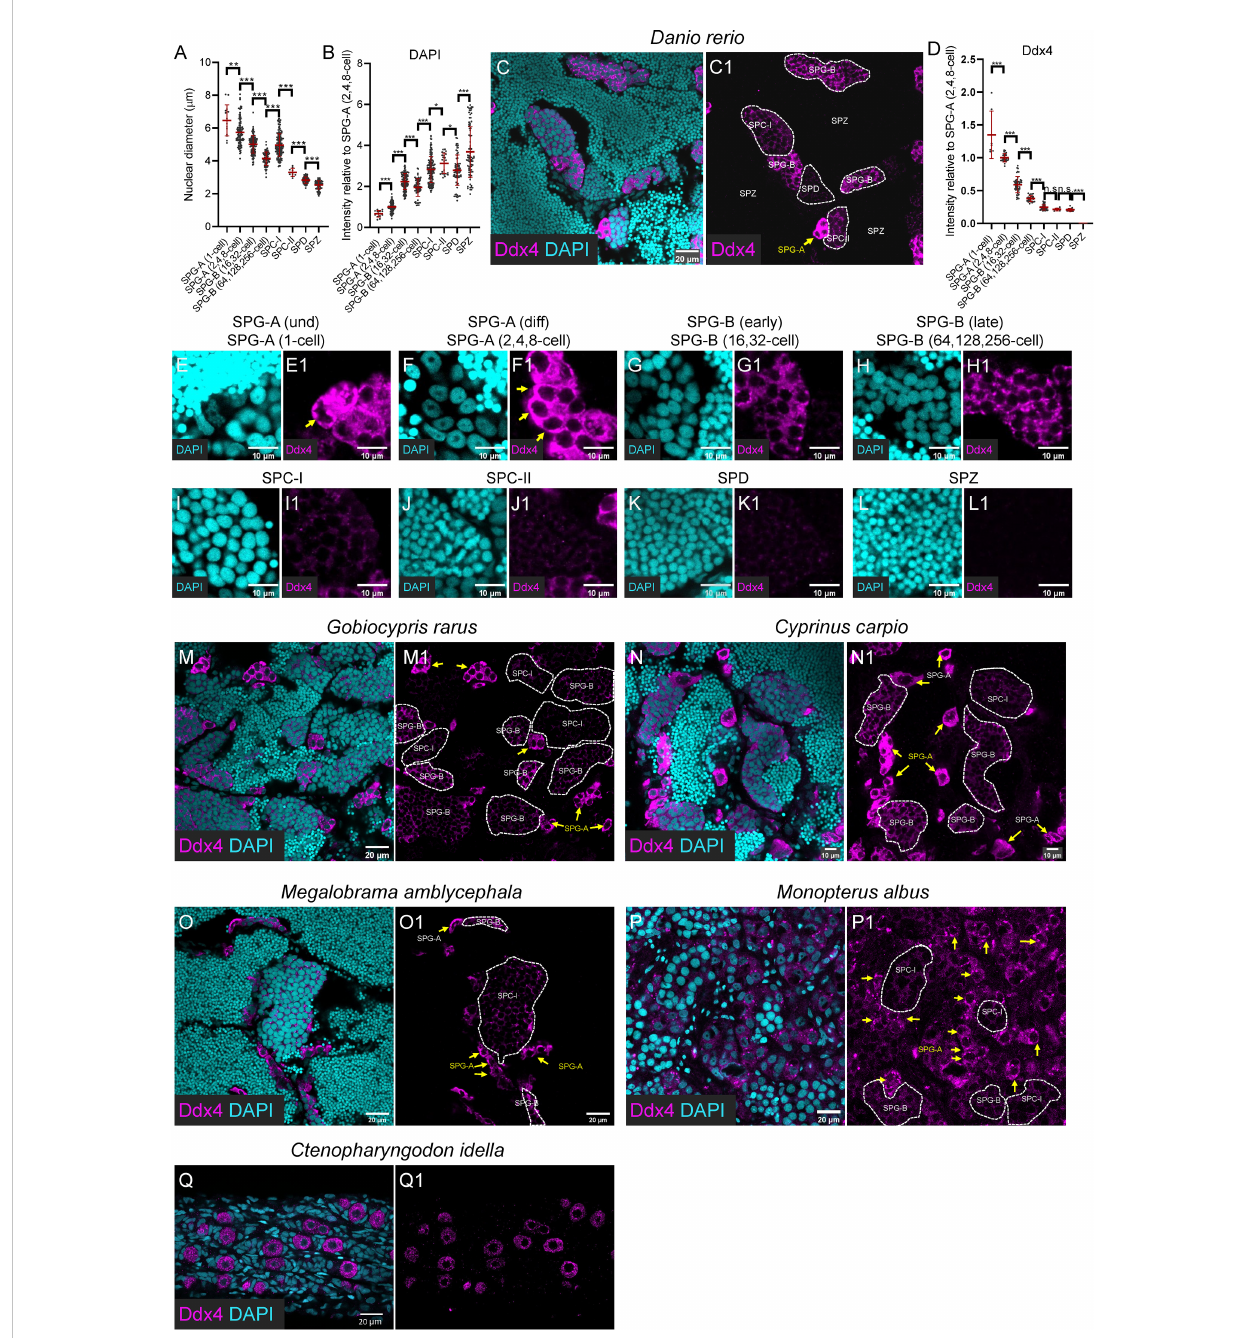
FIGURE 2 Progressively decreased expression of Ddx4 along spermatogenesis. (A) The graph showing the nuclear diameter of different types of spermatogenic cells. (B) The graph showing the DAPI intensity of different types of spermatogenic cells relative to that of the SPG-A(2,4,8-cell). (C, C1) Representative images of a zebra fi sh testis section showing the expression of Ddx4 (magenta) co-stained with DAPI (cyan). (D) The graph showing the Ddx4 intensity of different types of spermatogenic cells relative to that of the SPG-A(2,4,8-cell). (E-L, E1-L1) The Representative images showing the SPG-A(1-cell) (E, E1) , the SPG-A(2,4,8-cell) (F, F1) , the SPG-B(16,32-cell) (G, G1) , the SPG-B(64,128,256-cell) (H, H1) , the SPC-I (I, I1) , the SPC-II (J, J1) , the SPD (K, K1) and the SPZ (L, L1) . (M-P, M1, P1) The representative images showing the expression of Ddx4 in Gobiocypris rarus (M, M1) , Cyprinus carpio (N, N1) , Megalobrama amblycephala (O, O1) , Monopterus albus (P, P1) and Ctenopharyngodon idella (Q, Q1) . SPG-As are indicated by the arrows, and other types of spermatogenic cells are circled by dashed lines. All data were collected from three independent testicular samples. All values are the mean ± STD. Unpaired and two-tailed Student ’ s t-test were used to compare means. *P<0.05; **P<0.01; ***P<0.001, n.s. not signi fi